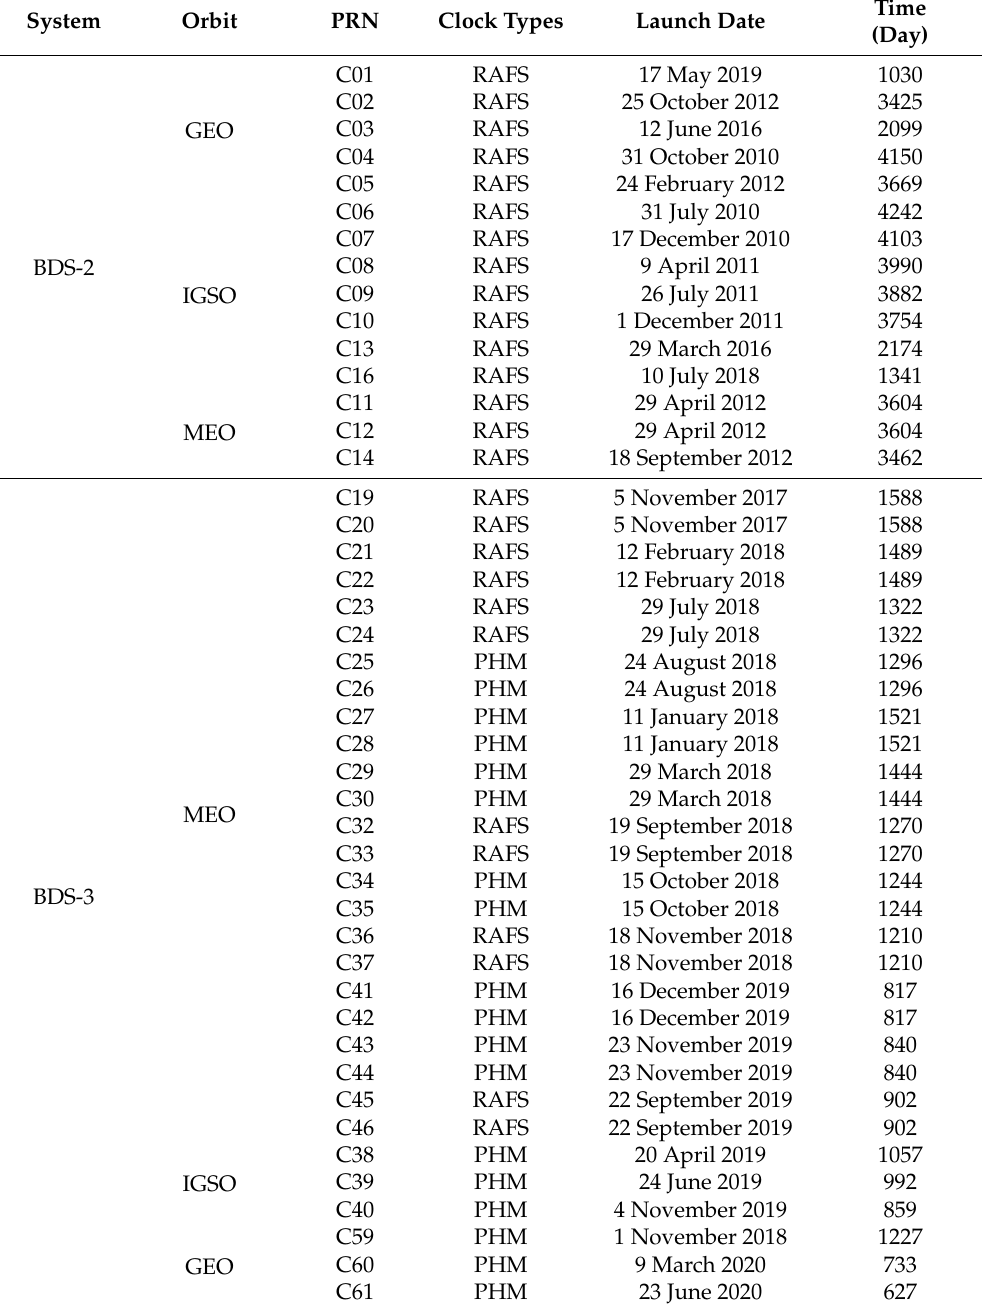
Table 1. The information of BDS on-orbit